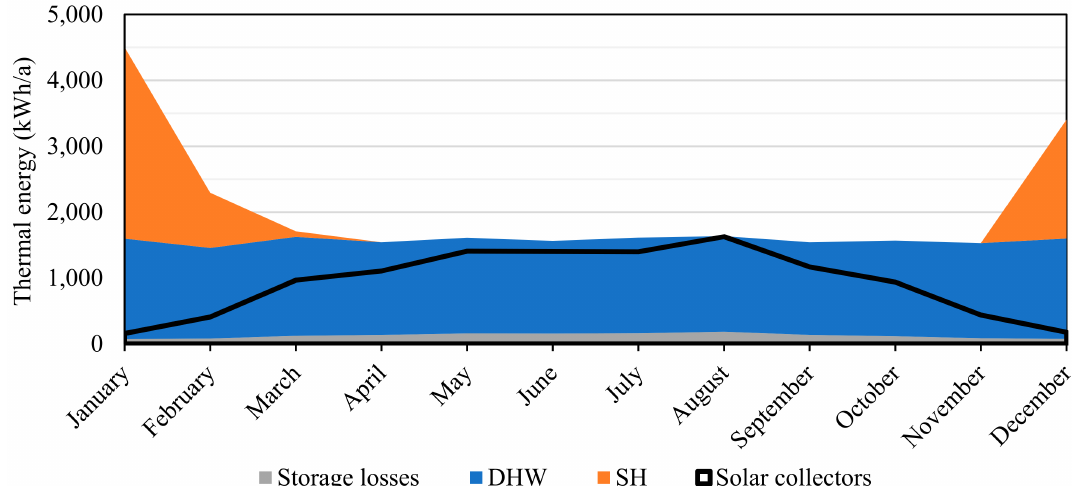
Figure 13. Monthly distribution of thermal energy delivered by solar collectors to the storage and the thermal energy needed for system